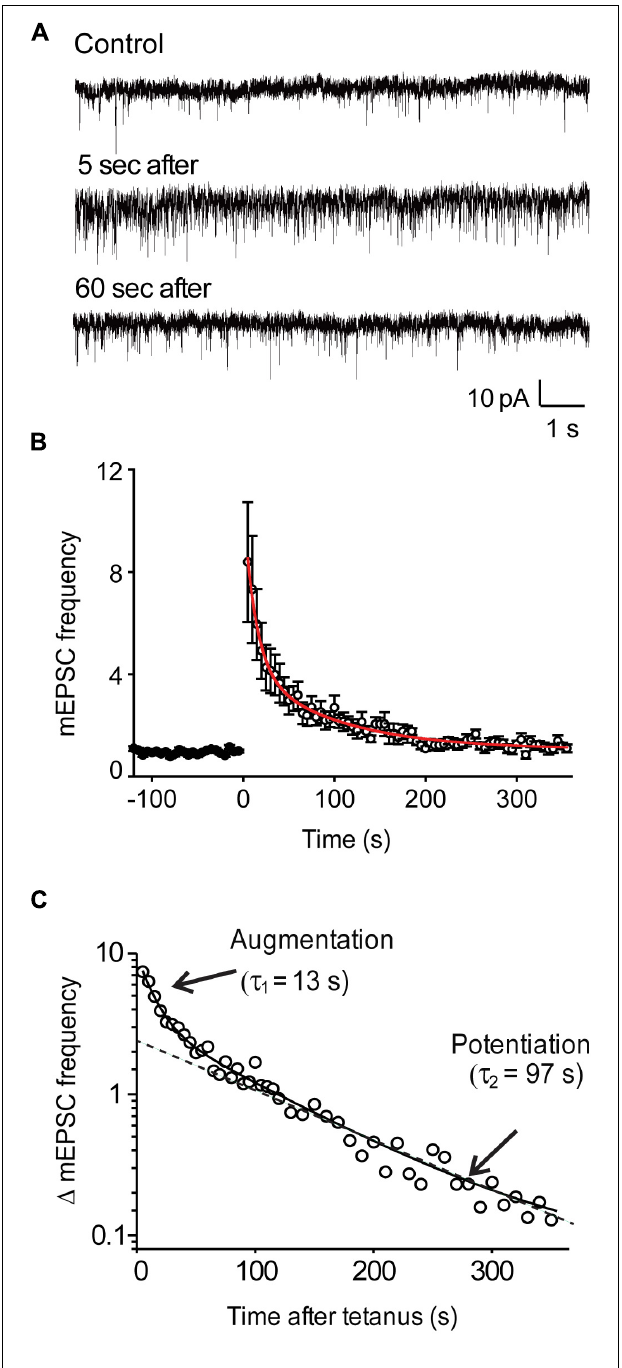
FIGURE 1 | Activity-dependent enhancement of miniature EPSC frequency in wild-type hippocampal neurons. (A) Representative recordings of mEPSCs before, as well as 5 and 60 s after the end of a stimulus train (50 Hz, 2 s). (B) Time course of mEPSC frequency changes produced by stimulation (at time = 0). Points indicate mean values of mEPSC frequency ( n = 9), normalized to baseline values measured prior to the stimulus train, and error bars indicate ± SEM. Red curve indicates fit of bi-exponential decay function. (C) Semi-logarithmic plot of the post-tetanic changes in mEPSC frequency shown in panel (B) . Solid curve indicates bi-exponential decay function, while dashed line indicates time course of slower potentiation